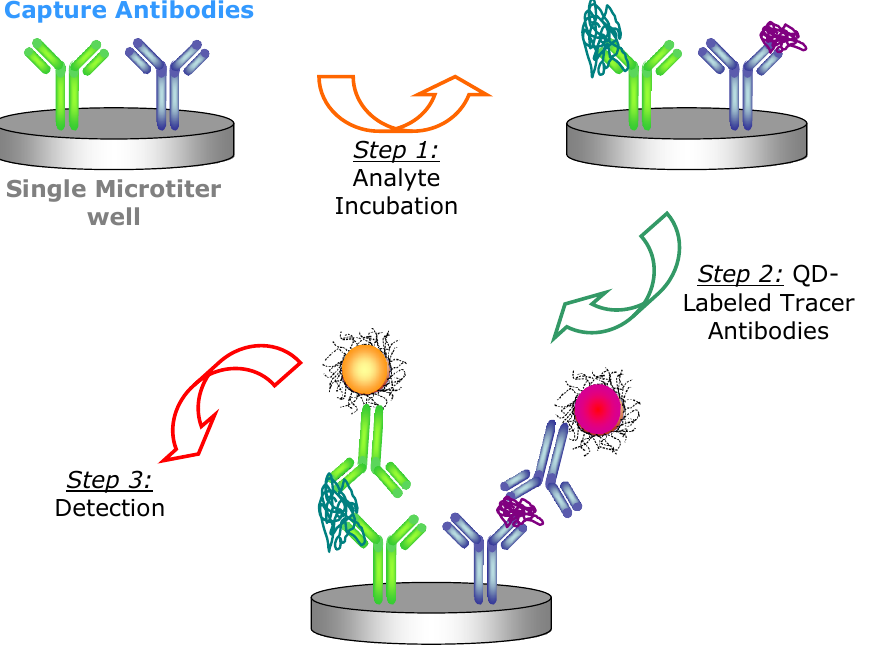
Figure 3. Scheme illustrating duplex detection in a single well of a microtiter plate using NC-based tracers. Not to